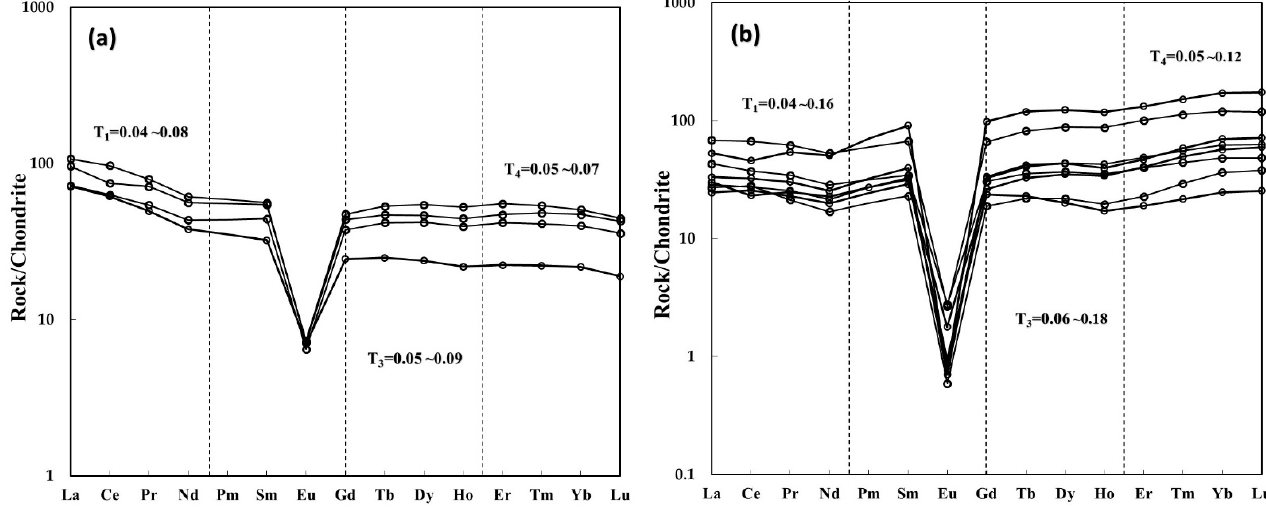
Figure 4. Chondrite [37]-normalized REE distributions for ( a ) A group; Eu/Eu * > 0.1 and ( b ) B group; Eu/Eu * < 0.1 among Pirrit Hills granite samples. The values of T 1 , T 3 , and T 4 were calculated following equations given in Monecke et al. [7].